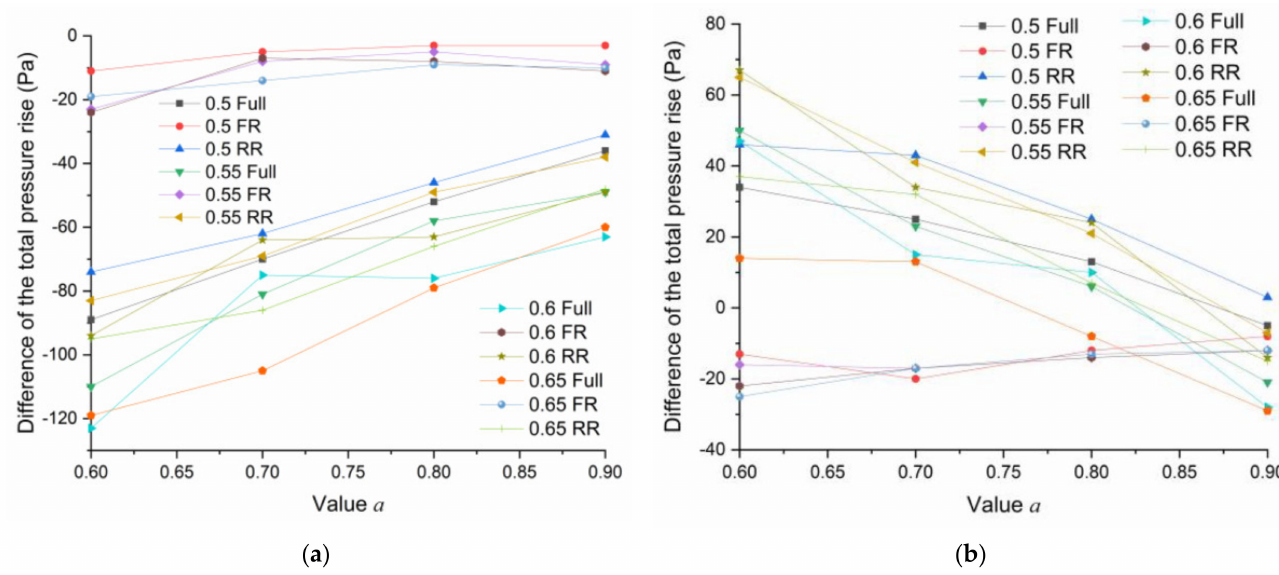
Figure 11. ( a ) Effect of value a on total pressure rise when controlling the FR; ( b ) effect of value a on total pressure rise when controlling the